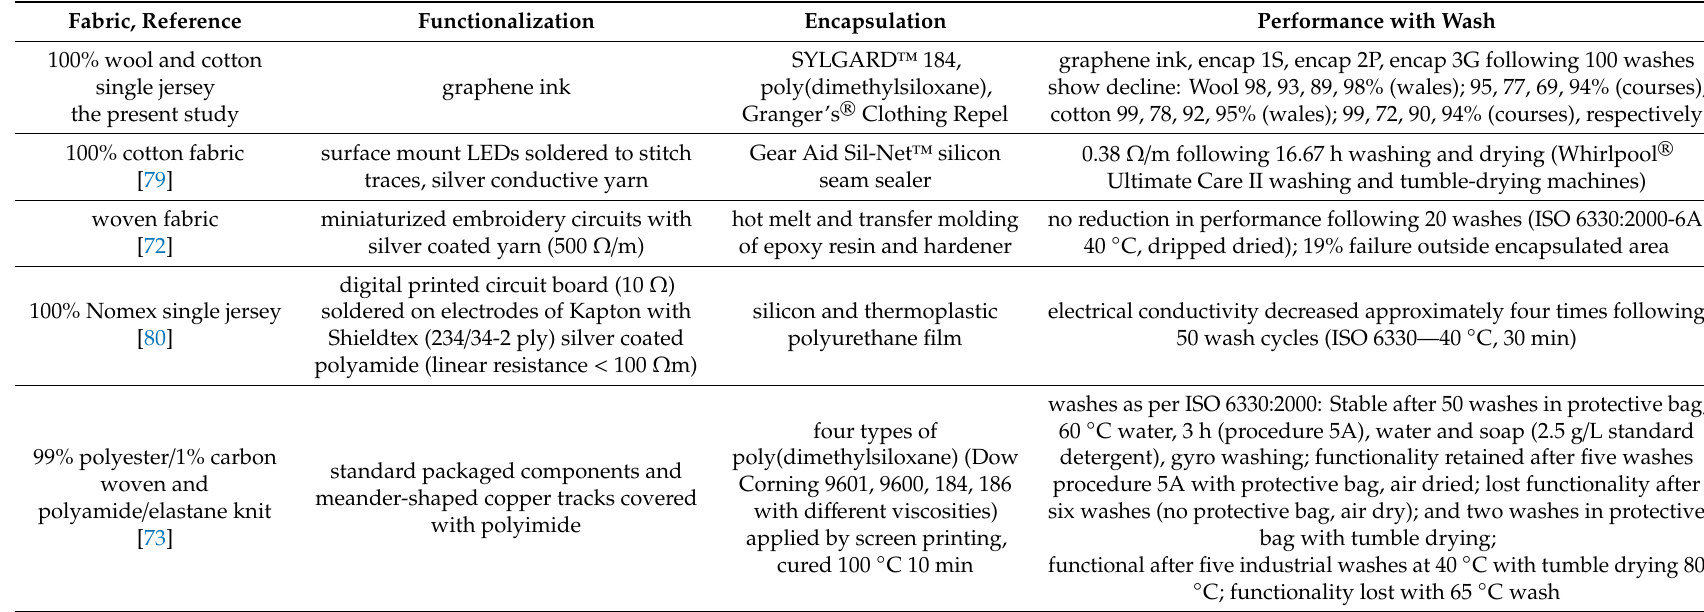
Table 6. Performance of encapsulated functionalized fabrics with